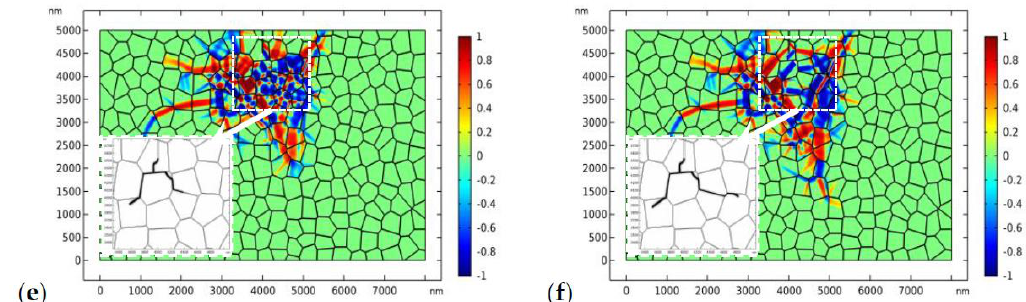
Figure 10. The evolution of the phase transformation and crack propagation in TZP (crystal orientation I) with “weak” GBs (plots represent η 1 − η 2 , and the crack is displayed in the amplified window separately), where the applied load is 170 MPa: ( a – f ) at times 0.4, 0.8, 1.2, 1.6, 2.0, and 2.8 μs , respectively.